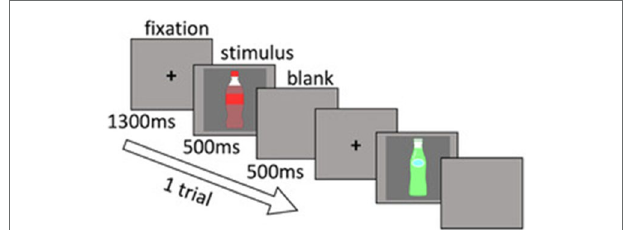
FIGURE 1 | Go/No-go task structure. Each trial was composed of fixation, stimulus, and a blank screen. Participants were asked to respond with a button press as soon as possible when the Go stimulus was presented and to withhold responses when the No-go stimulus was presented. Each session was composed of 140 Go trials and 60 No-go trials. Six sessions were conducted in total. The stimuli of No-go trials were alternately switched between high and low purchase frequency in every session. In order not to infringe copyrights and trademarks, the two product images of the stimuli in this figure are replaced with